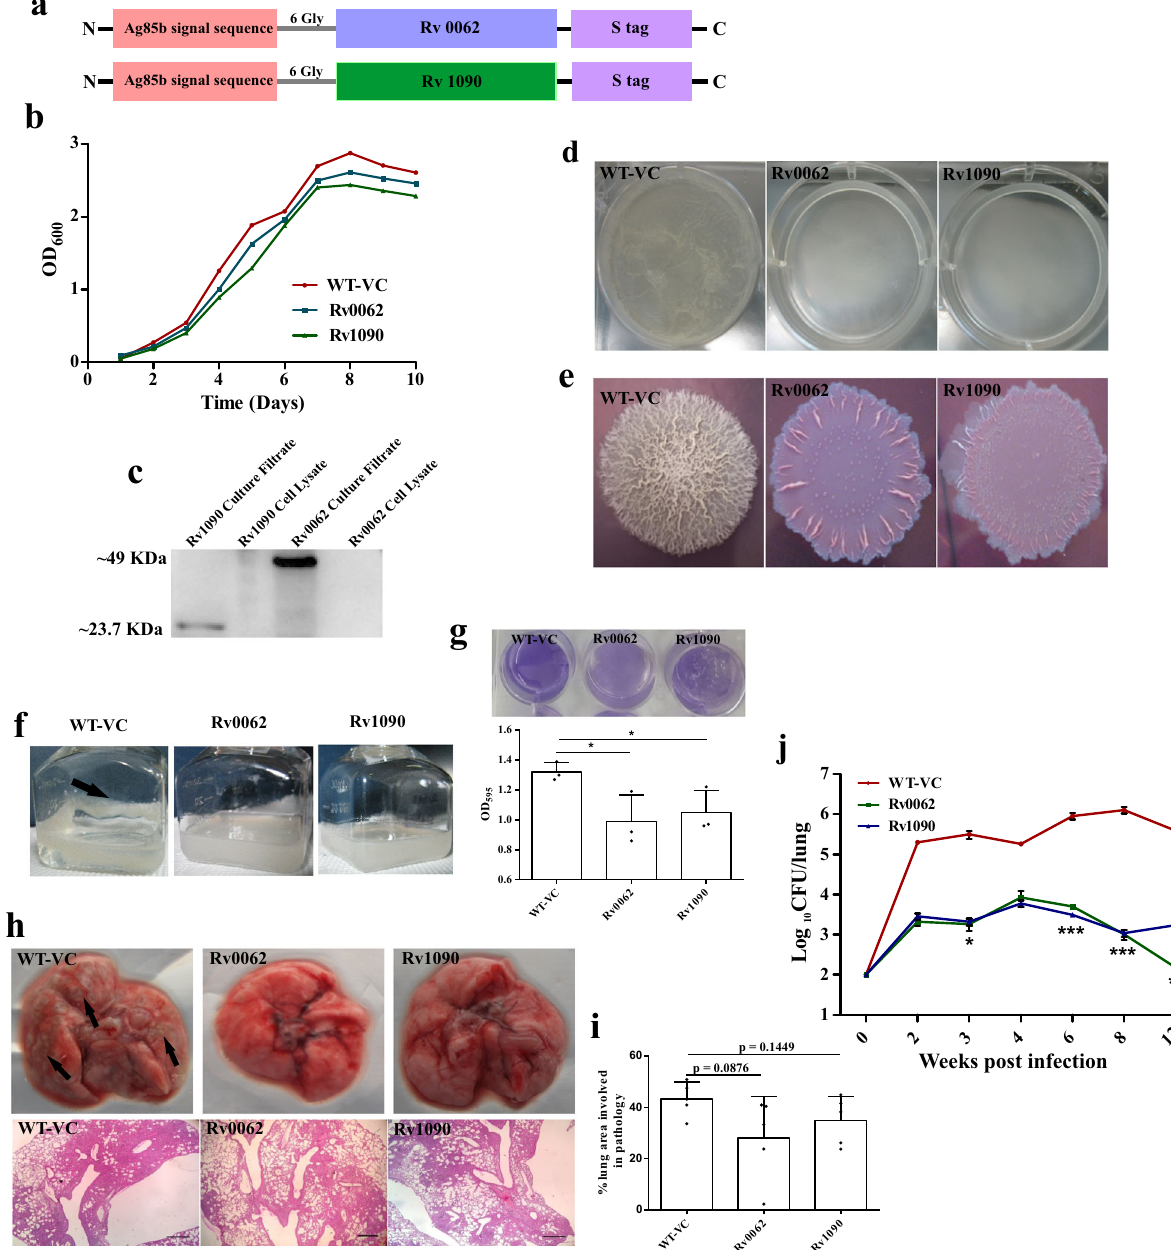
Fig. 8 Mtb bio fi lms protect the bacilli from the host immune system. a Construct design for engineering Mtb strains overexpressing endogenous Mtb cellulases (Rv0062 and Rv1090). b Growth pro fi le of planktonic cultures of Mtb strain with vector control or those overexpressing Rv0062 and Rv1090. c The culture supernatant of the above-described cultures was used in Western blot analysis. Antibodies speci fi c to S-tag were utilized to detect the secretion of cellulases outside Mtb cells. Uncropped image of the blot is provided in Source Data. d Pellicle bio fi lm pro fi le of WT-VC, Rv0062, and Rv1090, suggesting that cellulase overexpressing strains were severely defective in pellicle formation. e Macrocolonies of WT-VC, Rv0062, and Rv1090 on 7H11 agar supplemented with Congo red and Coomassie Brilliant Blue G250 dye. f , g Bio fi lms of WT-VC, Rv0062, and Rv1090 induced by thiol reductive stress using DTT shows defect in the engineered strains, as indicated by CV assay quantitation. The bio fi lm formed by WT-VC ( f ) has been shown by black arrow. h C57BL/6 J mice were independently infected with vector control (WT-VC) or strains overexpressing cellulases Rv0062 and Rv1090 using a low dose of aerosols. Gross lung pathology (upper panel) and histopathology (lower panel) of mice lungs infected with WT-VC, Rv0062, and Rv1090. i Lung pathology post-infection with Mtb strains, as mentioned in h , was quantitated using ImageJ software. j Survival inside mice lungs ( n = 5) was estimated using CFU analysis. The data presented in fi gures g , i and j have been plotted in GraphPad Prism 6 and represented as mean (±s.e.m). Statistical signi fi cance of j was determined using two way ANOVA. * P < 0.05, ** P < 0.01, *** P < 0.001. And the statistical signi fi cance of g and i was determined using Student ’ s t -test (two tailed). For g * P = 0.0375 (column A vs column B) and * P = 0.0431 (column A and column C). All data are representative of three independent biological experiments performed in triplicates unless otherwise mentioned. Scale bars correspond to 200 μ m. All source data are provided as a Source Data fi